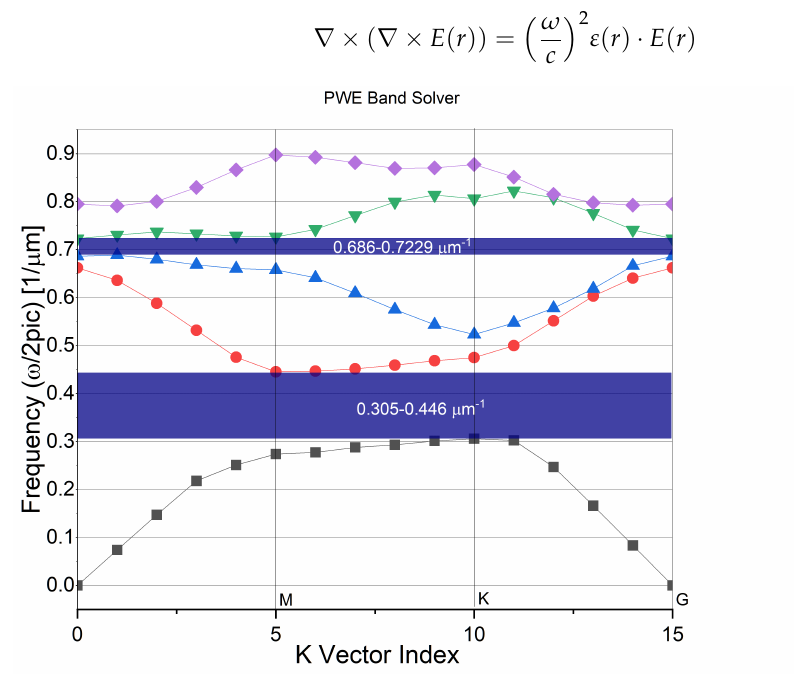
Figure 3. Photonic bandgap of the design